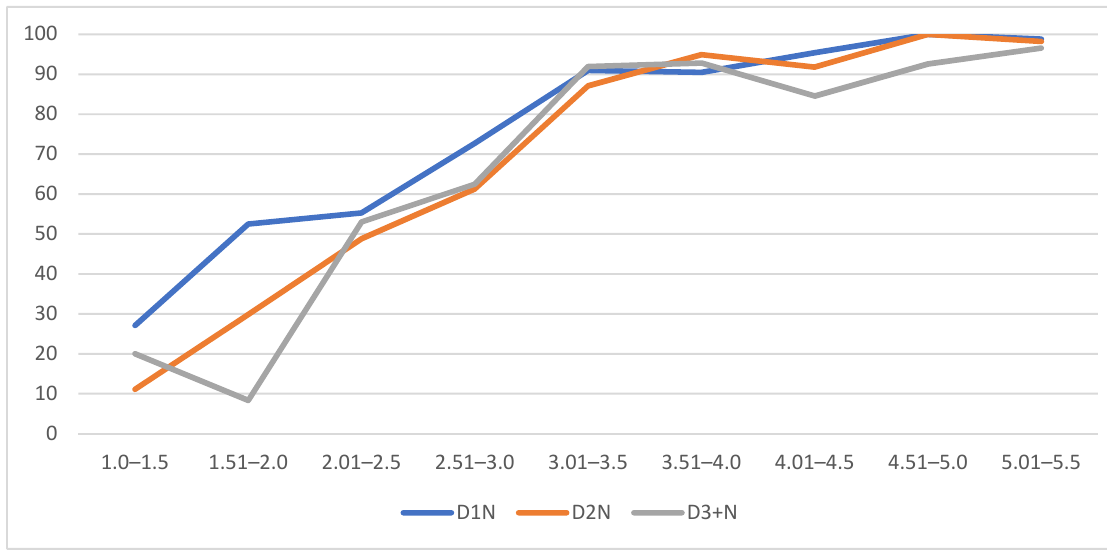
Figure 3. Ju_fi’s D realizations according to noun length (%).